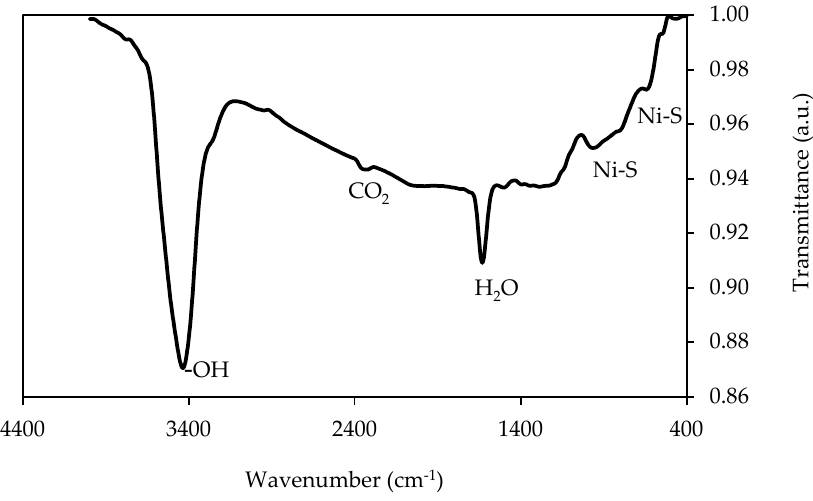
Figure 5. FTIR spectrum of the as ‐ synthesized NiS nanoparticles.